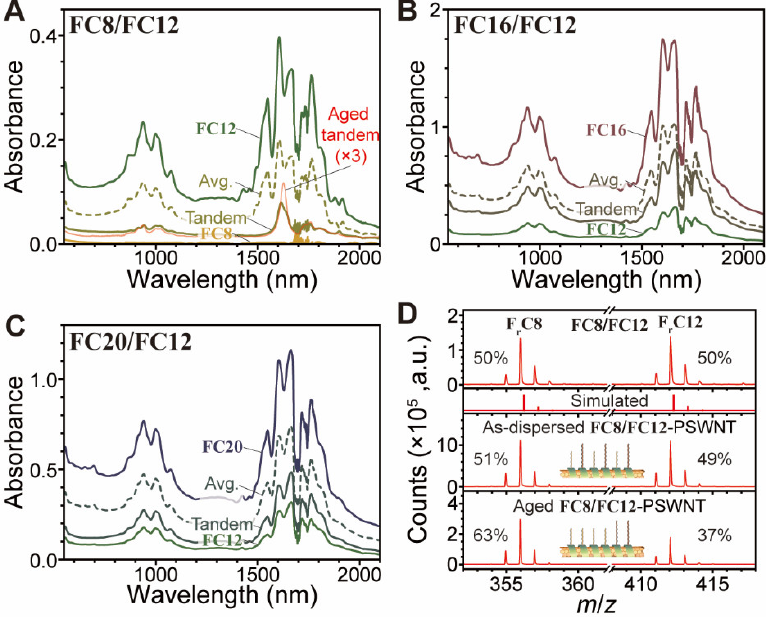
Figure 11. Absorption spectra of PSWNT dispersions generated using isomolar tandem mixtures of flavin surfactants ( A ) FC8/FC12 , ( B ) FC16/FC12 , and ( C ) FC20/FC12 , compared to those from respective single surfactant dispersion, averaged, and aged tandem samples. All measurements except the aged dispersion were acquired by using a cuvette of beam path 10 mm. The average spectra were obtained by averaging each single flavin spectrum. ( D ) MALDI-TOF MS spectra of (top) isomolar FC8 / FC12 solution, (middle) surfactants present on the as-prepared FC8 / FC12 -PSWNT, and (bottom) surfactants present on the aged FC8 / FC12 -PSWNT.